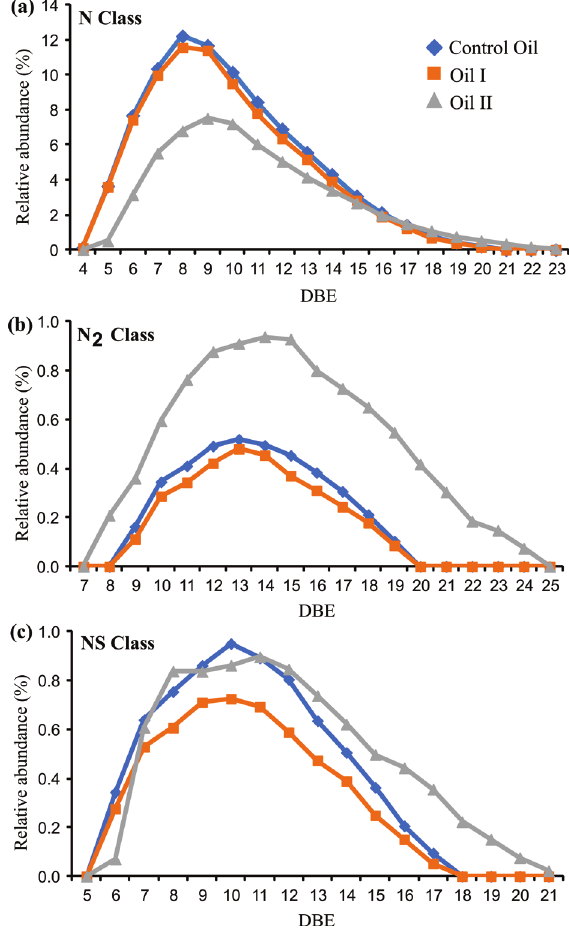
Figure 5. DBE distribution of the N (a), N (c) classes in the Control Oil and the recovered Oils I (from waterflooding) and II (from